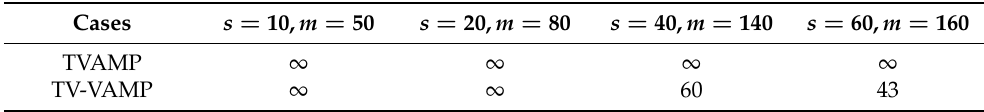
Table 3. Average number of iterations to achieve NMSE = − 60 dB for ill-conditioned measurements